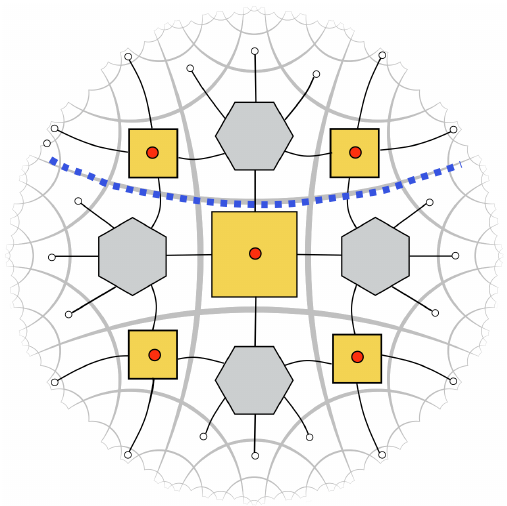
Figure 29. A two-layer hybrid tensor